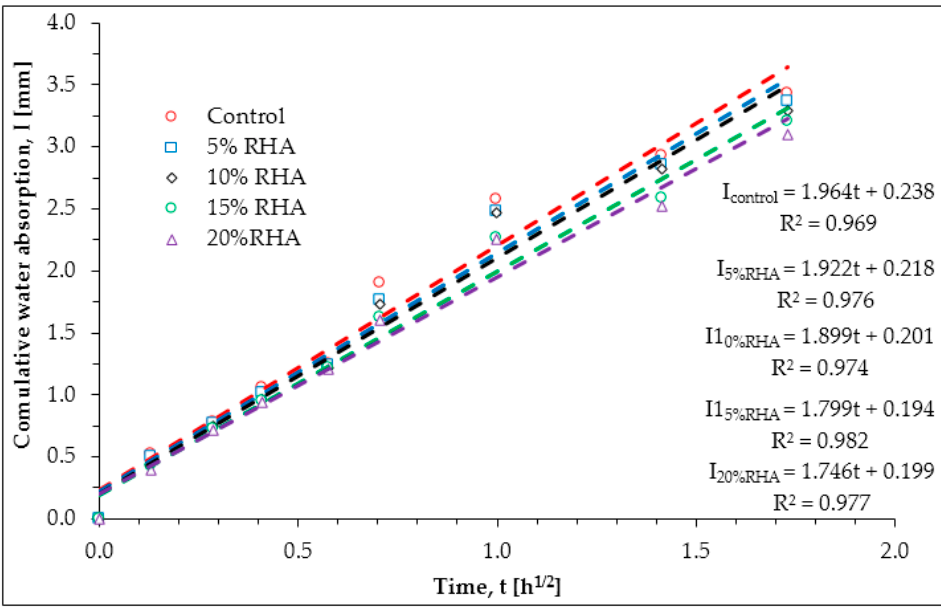
Figure A1. Cumulative water absorption by RHA Concrete.